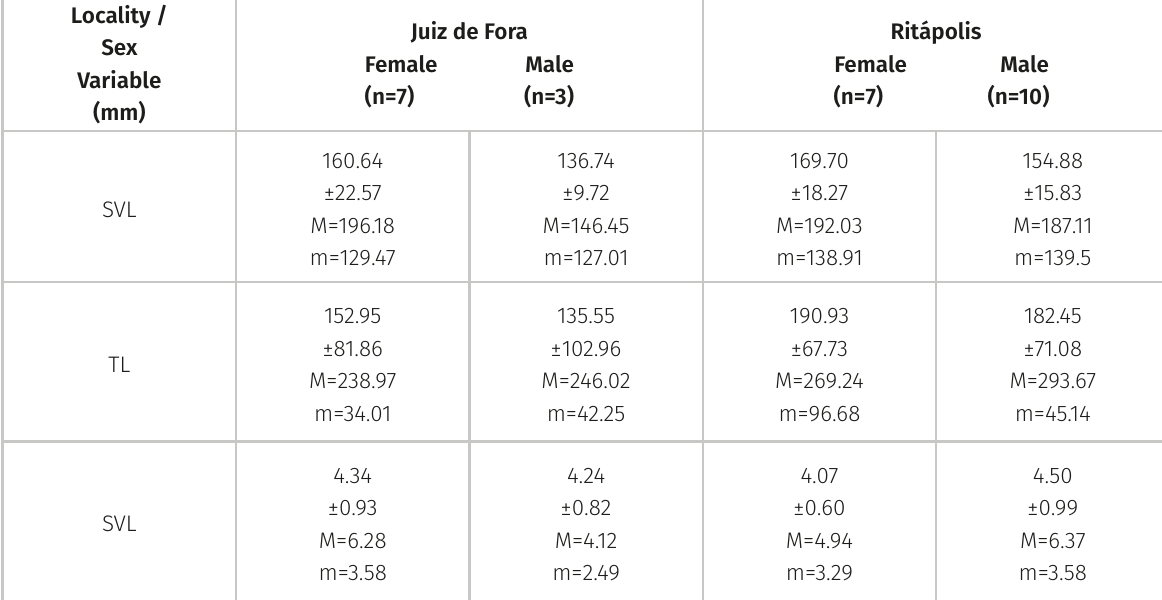
Table II. Means calculated for the snout-vent length (SVL), tail length (TL), length of the vestigial hind limbs (LVL) of the females and males specimens of Ophiodes striatus belonging to the Federal University of Juiz de Fora - Reptiles (CHUFJF-Reptiles) collected in previous studies in the municipalities of Juiz de Fora and Ritápolis - Minas Gerais,